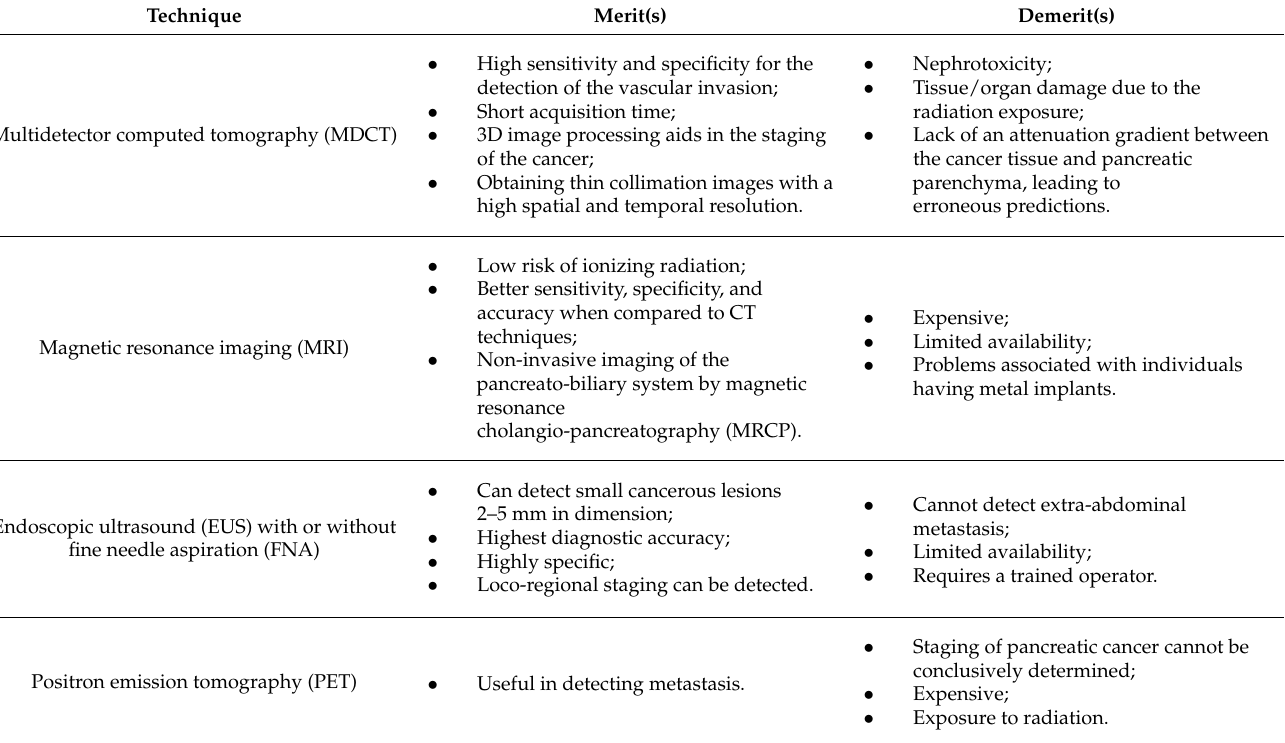
Table 1. Major imaging techniques employed for the diagnosis of pancreatic cancer and their